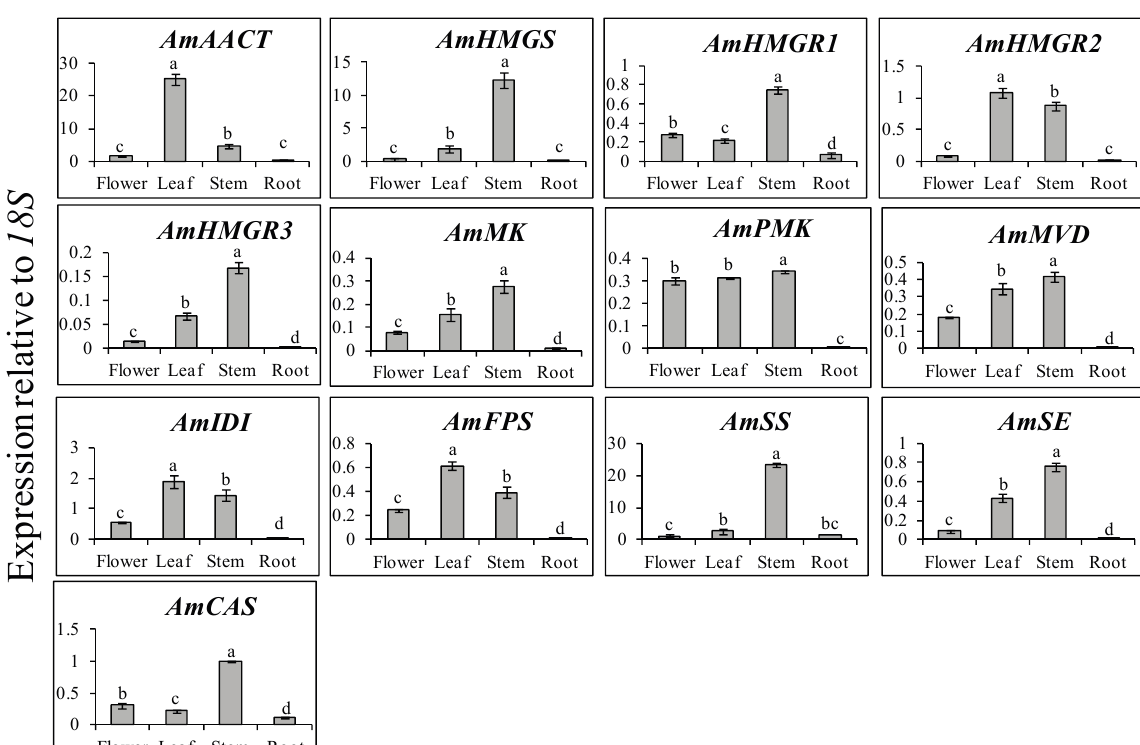
Figure 1. Transcript levels of triterpenoid biosynthetic genes in the flower, leaf, stem, and root of Huangqi. The height of each bar and the error bars show the mean and standard error, respectively, based on 3 independent measurements. Mean values indicated by the same letter are not significantly different at p ≤ 0.05, using Duncan Multiple Range Test ( n =